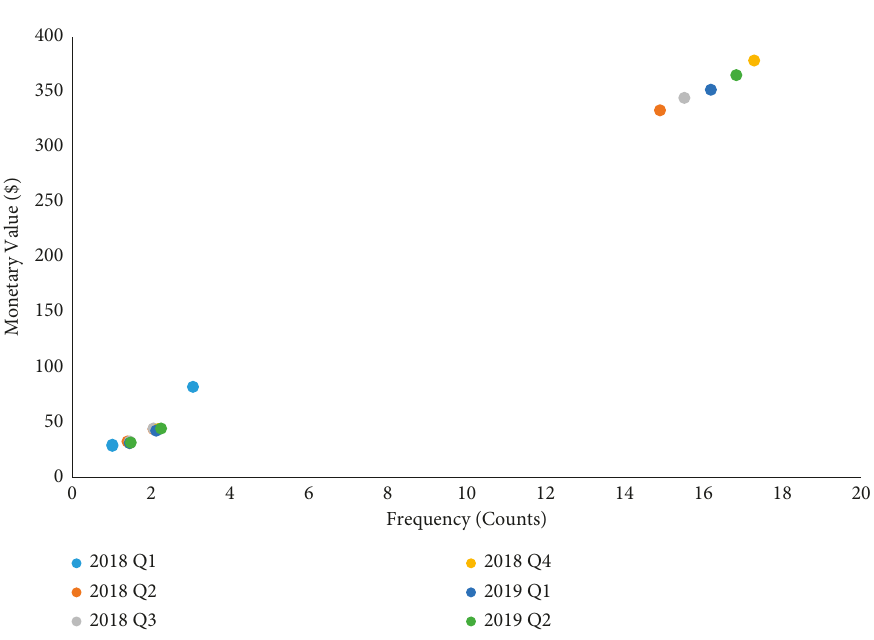
Figure 10: Target segment identification based on transit travellers’ relative frequency ( F ) and monetary value ( M ). Points represent clusters 1, 2, and 3 for the 2018 and 2019